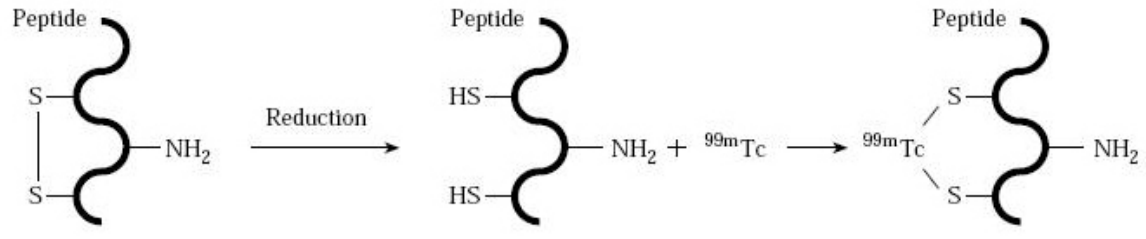
Figure1. Method for direct labeling of the